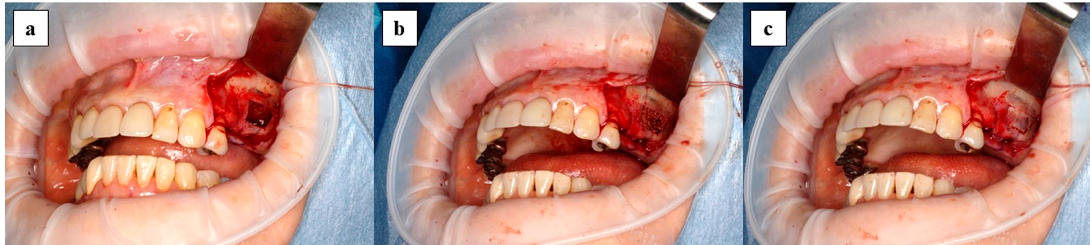
Figure 3. Surgical procedure of maxillary sinus floor augmentation is shown: ( a ) bone window is removed and the maxillary sinus mucous membrane is elevated; ( b ) complex of x3FD-PRP and bone grafting materials are transplanted; ( c ) bone window is repositioned.